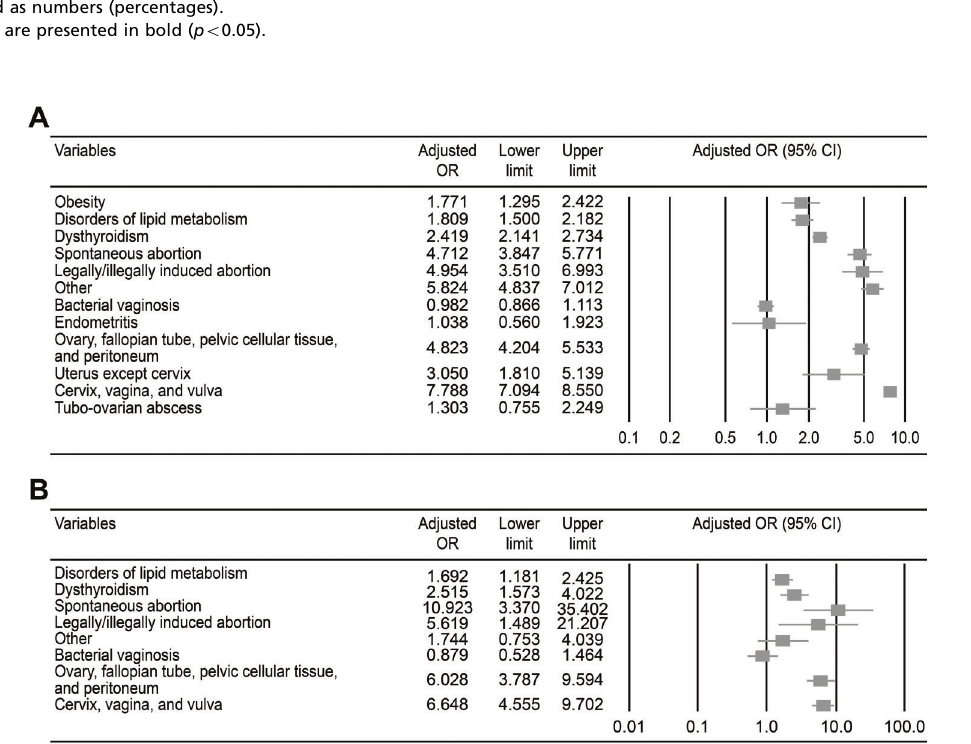
CI, confidence interval; OR, odds ratio. Data are reported as numbers